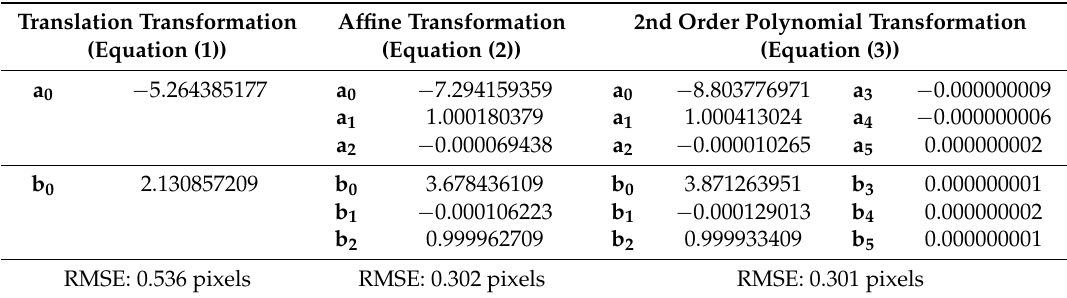
Table 3. Cape Town transformation coefficients and RMSE (Equation (5)) derived by fitting the 797 tie-points extracted from the Landsat-8 week 47 image and Sentinel-2A week 51 image. Translation Transformation